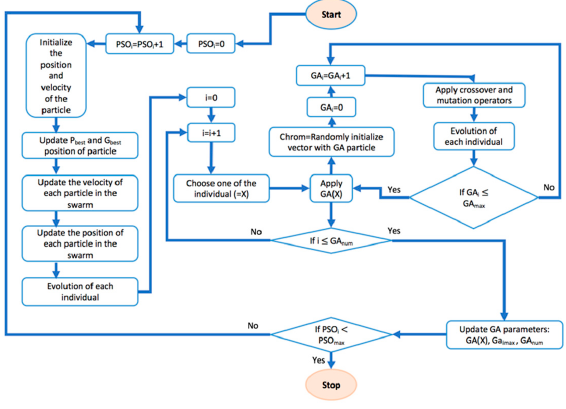
Figure 6. The hybrid method of Harish Garg.